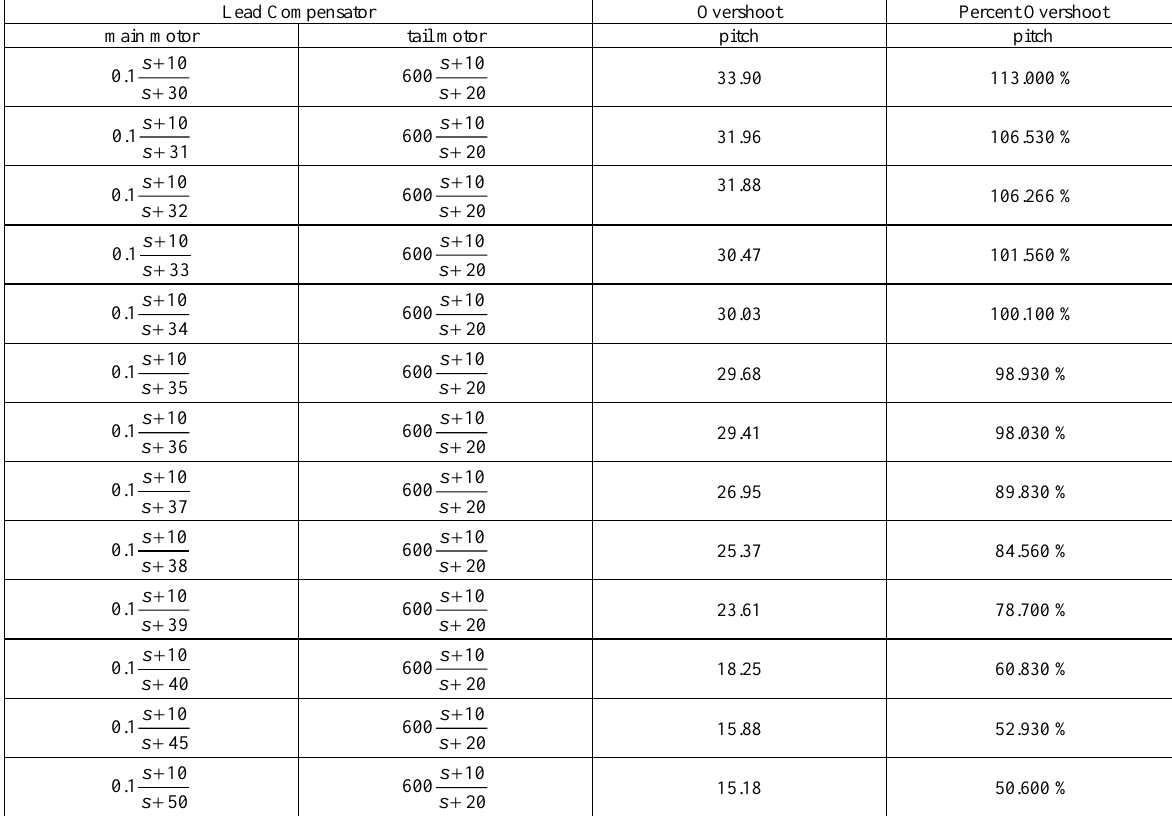
C OMPARISON OF O VERSHOOT IN A NGULAR P ITCH P OSITION AND P ERCENTAGE FOR D IFFERENT L EAD C OMPENSATORS A PPLIED ON THE M AIN M OTOR Lead